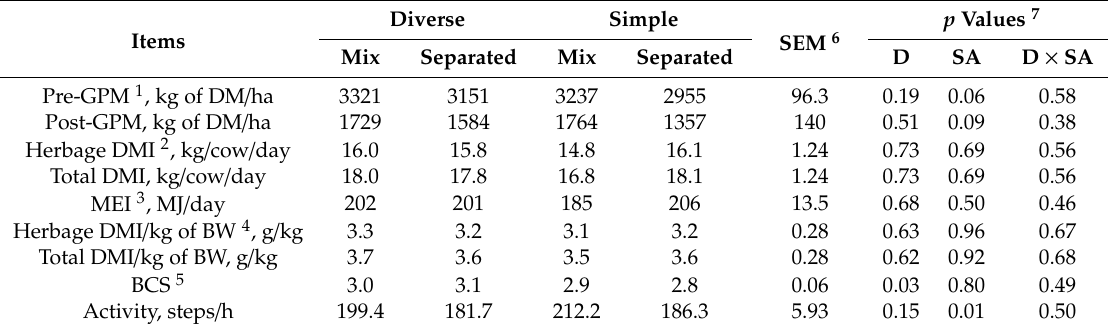
Table 1. E ff ect of pasture diversity (diverse or simple) and spatial arrangement (mix or separated) on herbage mass, apparent intake, and body